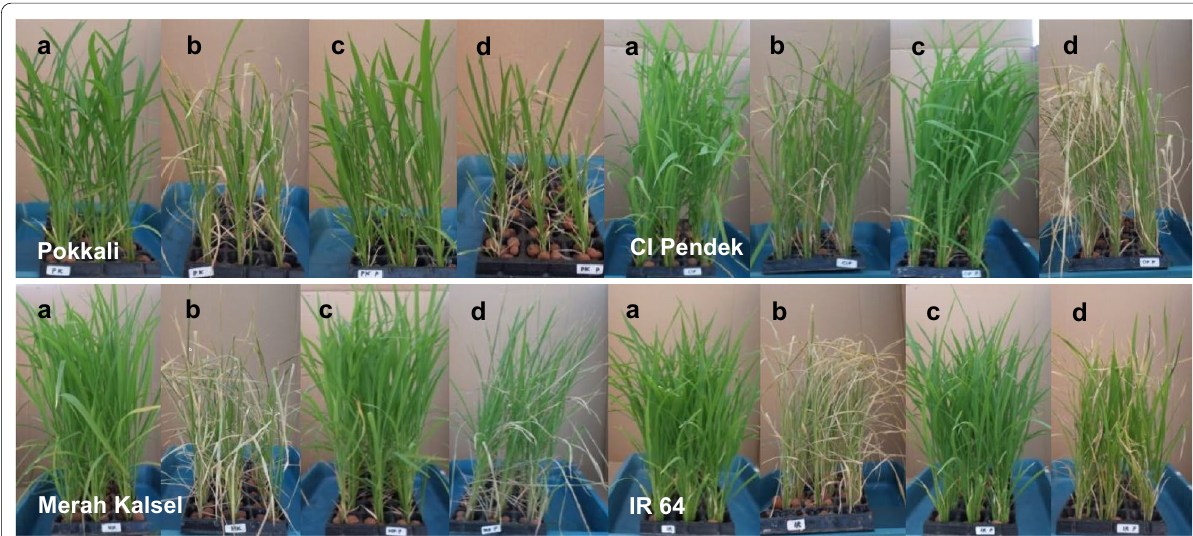
Fig. 1 Most of the tested cultivars were less affected by salinity stress after priming. For each cultivar, an example of the following treatment groups is shown: (from left to right) a unprimed and non-stressed, b unprimed and stressed with 200 mM NaCl solution, c primed and non-stressed, and d primed and stressed with 200 mM NaCl solution